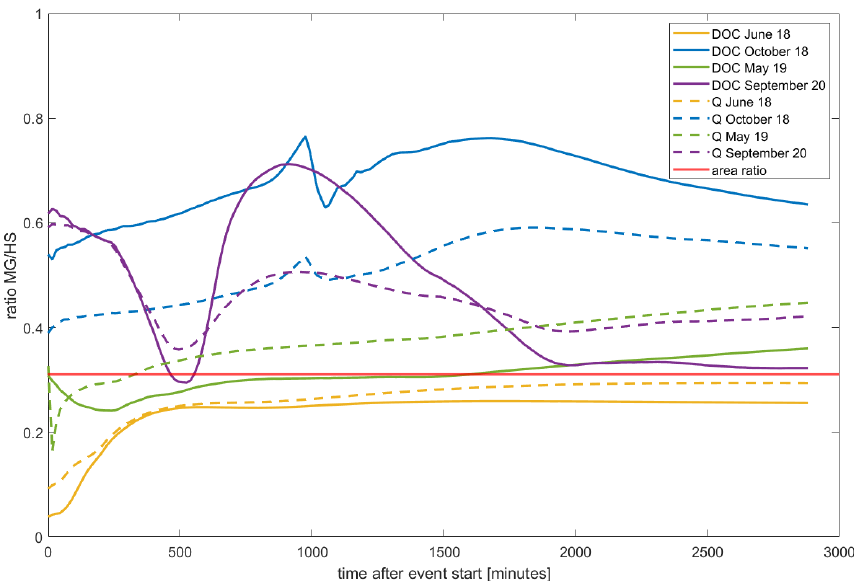
Figure 6. Ratio of cumulative Q (dashed lines) and DOC load (solid lines) at HS and MG during the four selected events. The red line indicates the expected ratio in terms of area (0.31). We included a 3h lag of the arrival from MG at HS based on flow velocity measurements taken at high